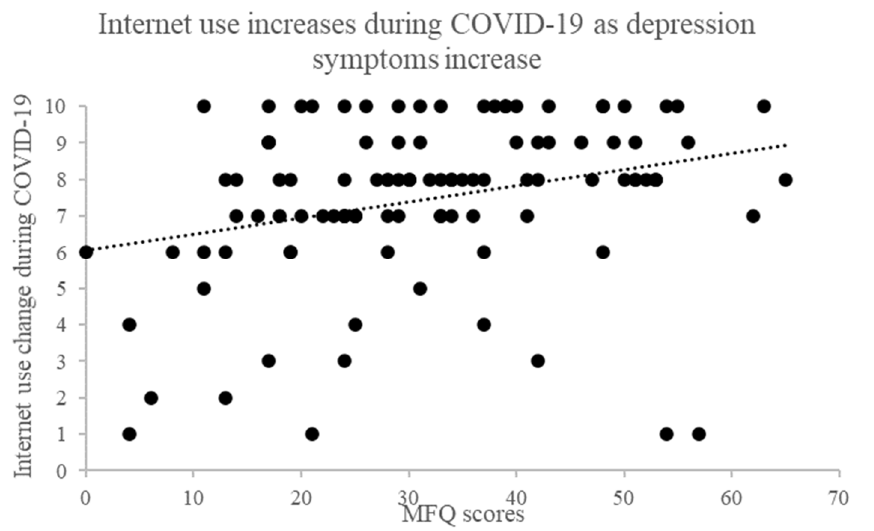
Figure 2. Correlation between MFQ and internet use during COVID-19.